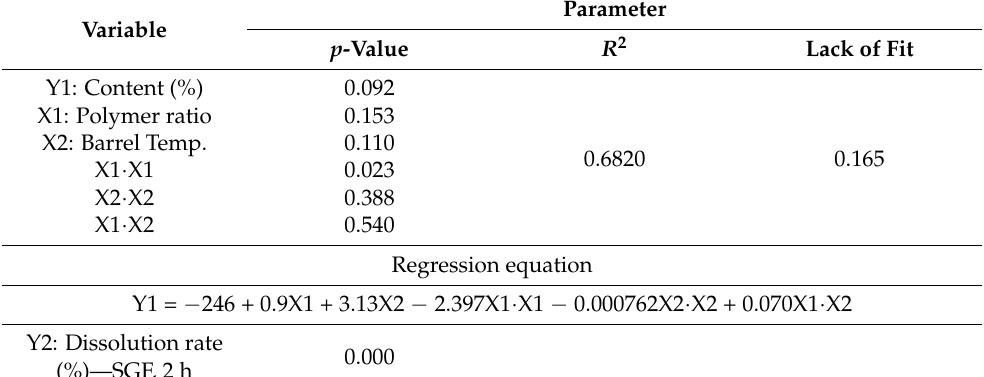
Table 5. ANOVA results for all